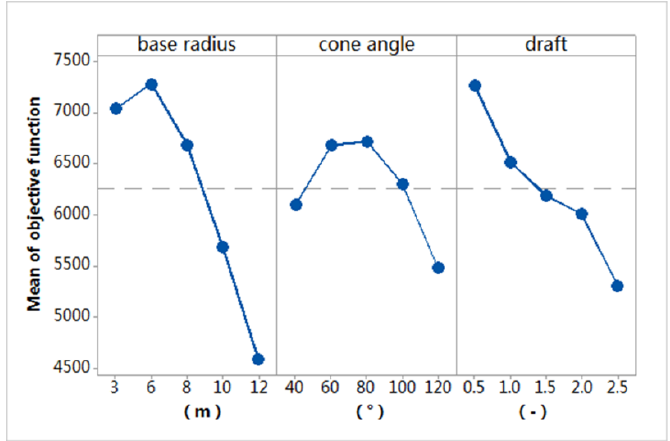
Figure 6. Main effects diagram for objective function.